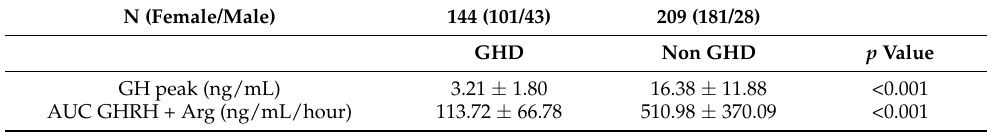
Table 1. GH secretion parameters in the study population (282 women–71 men).